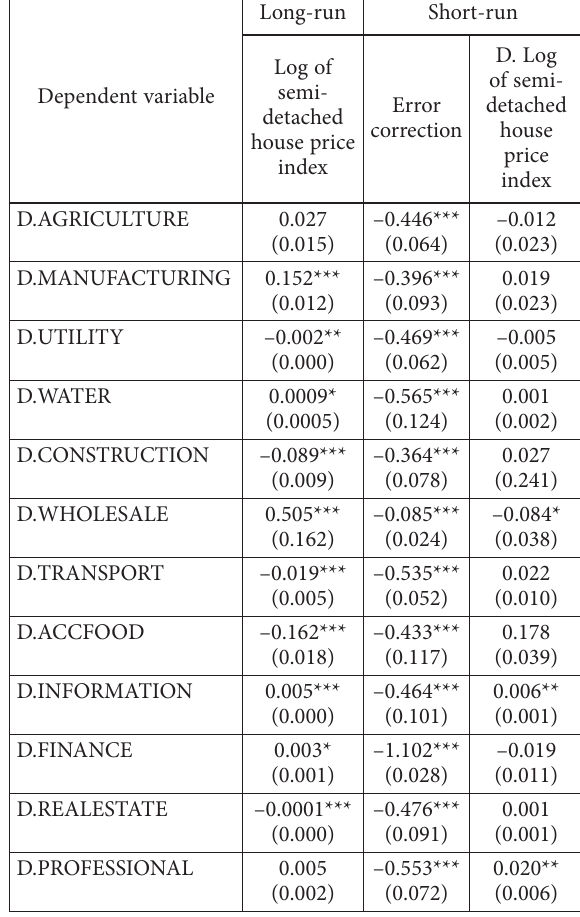
Table 7. Semi-detached house price index and